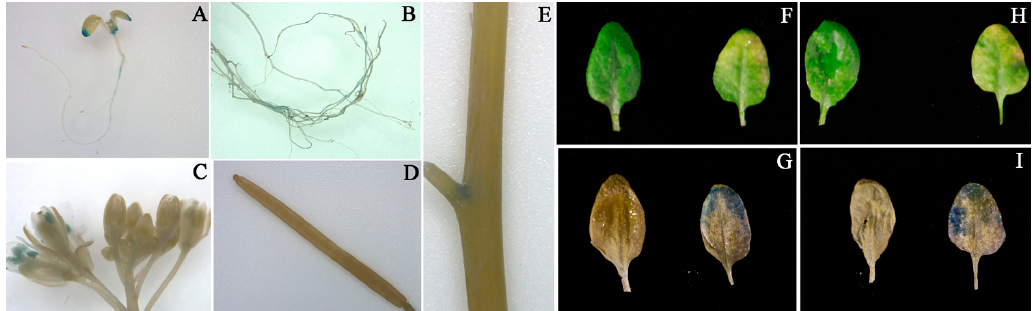
Figure 6. Tissue specific expression of CmNAC60 in transgenic Arabidopsis . ( A ) Seven-day-old seedlings. ( B ) Root, ( C ) inflorescence, ( D ) immature silique, and ( E ) stem of a six-week-old plant. ( F , H ) Non-senescing and senescing rosette leaves of a six-week-old plant before GUS staining. ( G , I ) Rosette leaves after GUS staining corresponding to ( F,H ).